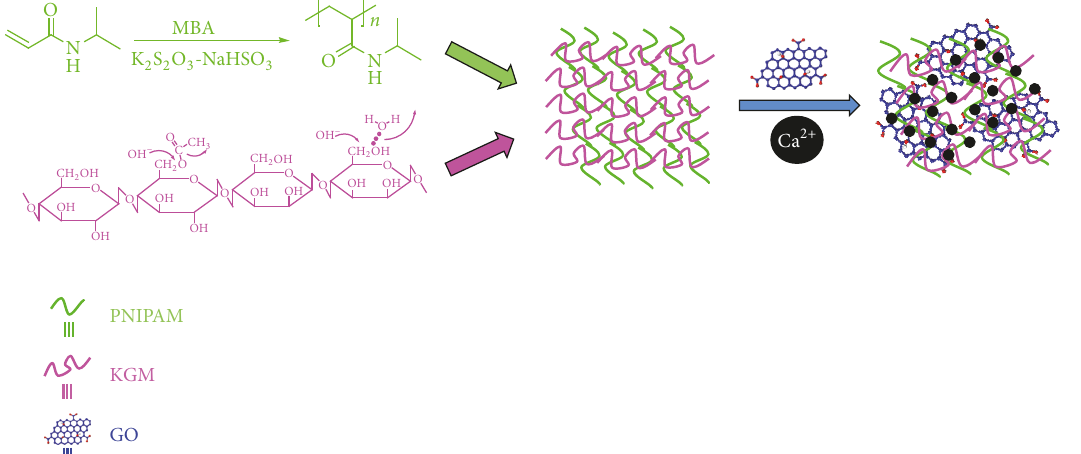
Scheme 1: Possible mechanism of PNIPAM/KGM/GO composite